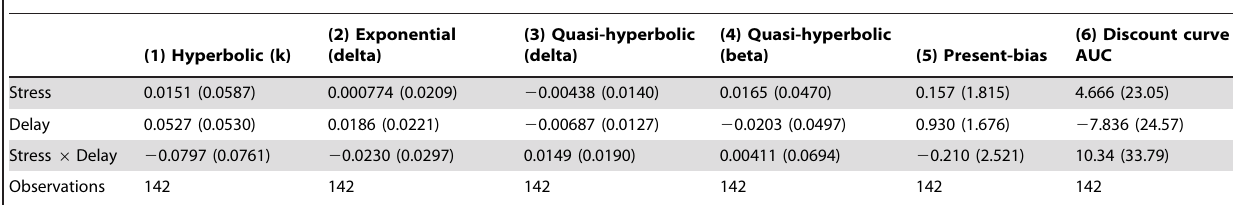
Table 2. Effect of stress manipulation on time preference model